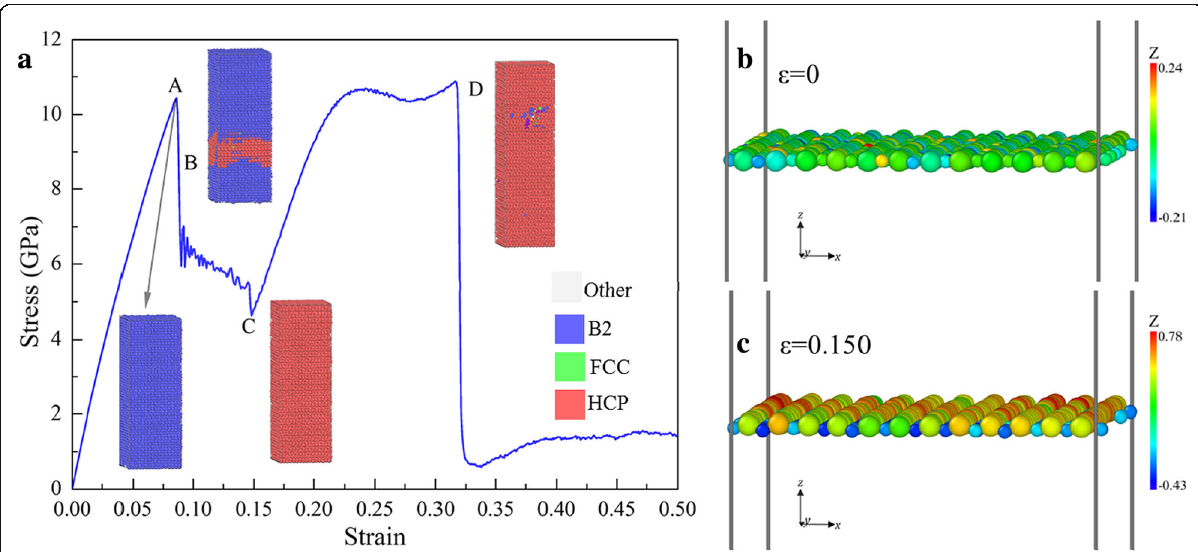
Fig. 11 a Deformation behavior of tension along [110], colored with PTM. b , c Atomic slices on xoy plane at ε = 0 and 0.150,